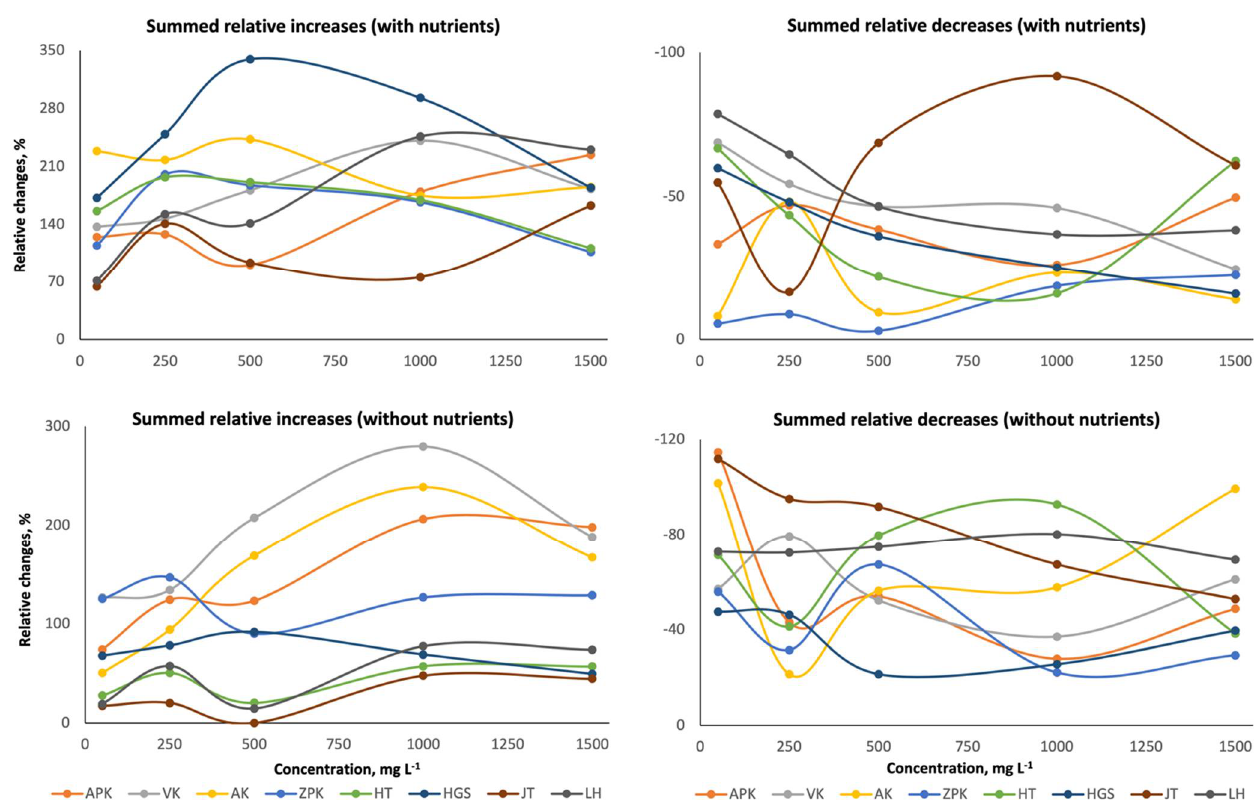
Figure 7. Aggregate relative increases and decreases in results yielded by the tested products by all parameters over a concentration range of HS solutions of different origins, with and without added nutrient solution. RBP = raised bog peat, VC = vermicompost, SC = soil compost, LMP = low moor peat, HT = Humin Tech potassium humate, HGS = Humic Growth Solutions potassium humate, JT = Jin Tai FA, LH = Lignohumate humic acid.